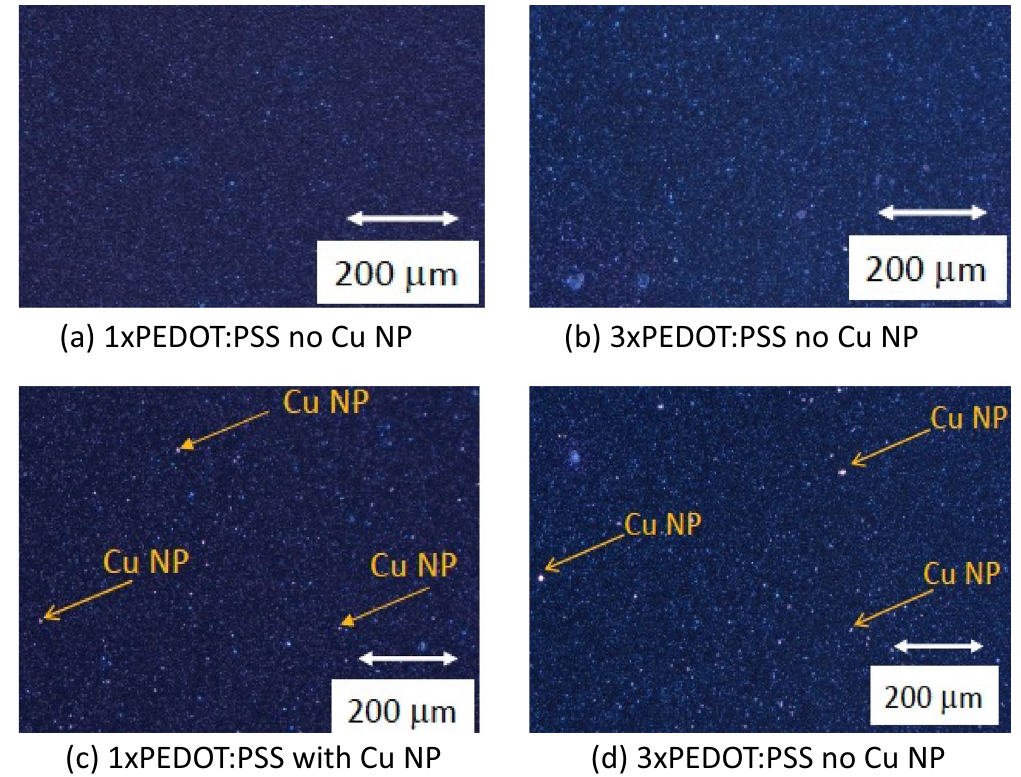
Figure 6. Optical microscope picture of PEDOT:PSS with and without Cu NP. ( a ) single coating of PEDOT:PSS deposited at 1500 rpm with no Cu NP. ( b ) a triple coating of PEDOT:PSS doped with 2 mg/ml of Cu NP. ( c ) a single coating of PEDOT:PSS deposited at 1500 rpm with Cu NP. ( d ) a triple coating of PEDOT:PSS deposited at 1500 rpm with 0.5 mg/ml of Cu NP.